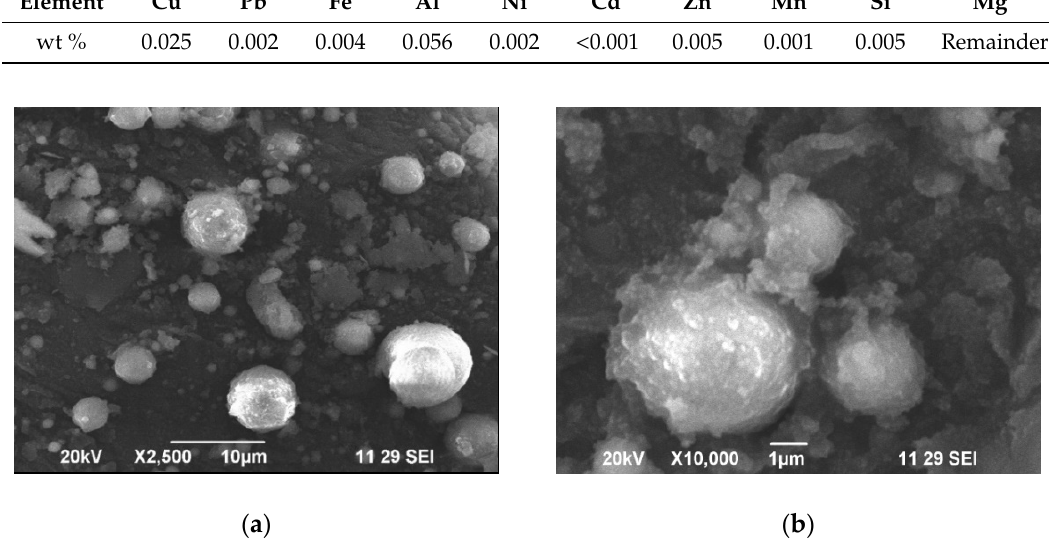
Figure 1. ( a , b ) Scanning electron microscope (SEM) images of Nitinol particulate (NiTi p ) used in the present study.